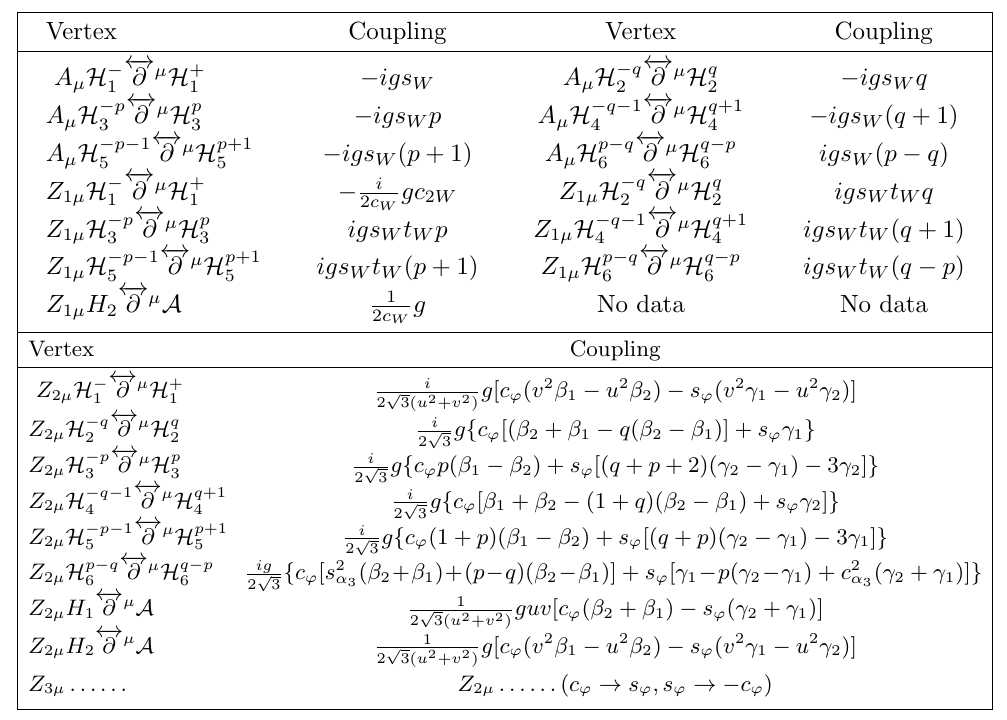
Table 8 . The interactions of a neutral gauge boson with two